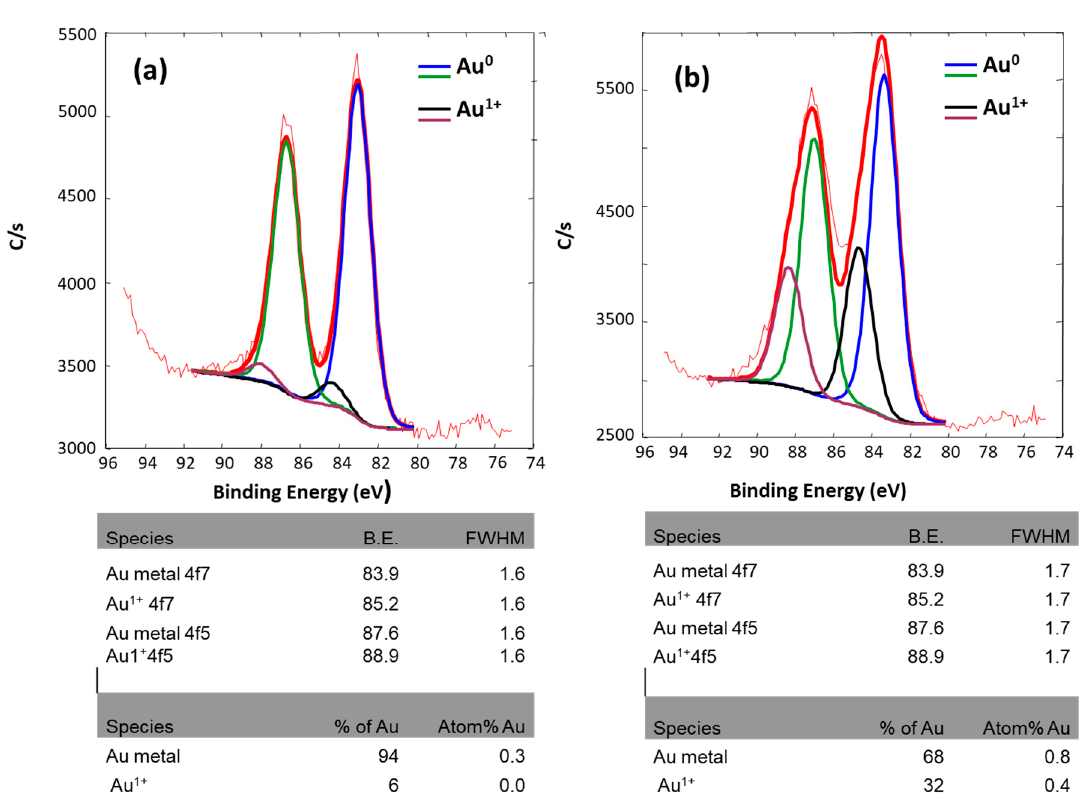
Figure 5. Curve fitting of Au 4f spectrum and relevant species of fresh 5% Au/CeO 2 prepared by ( a ) LVCC method and ( b ) DP method.